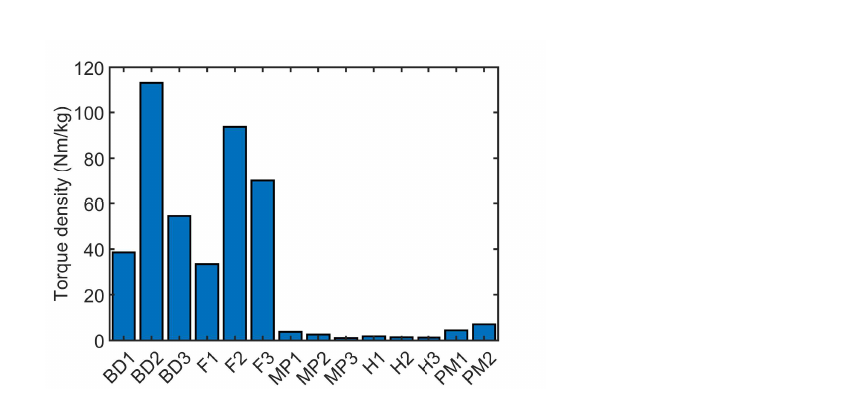
Figure 16. Torque density comparison of commercially available torque limiters (approx. 10 Nm range).